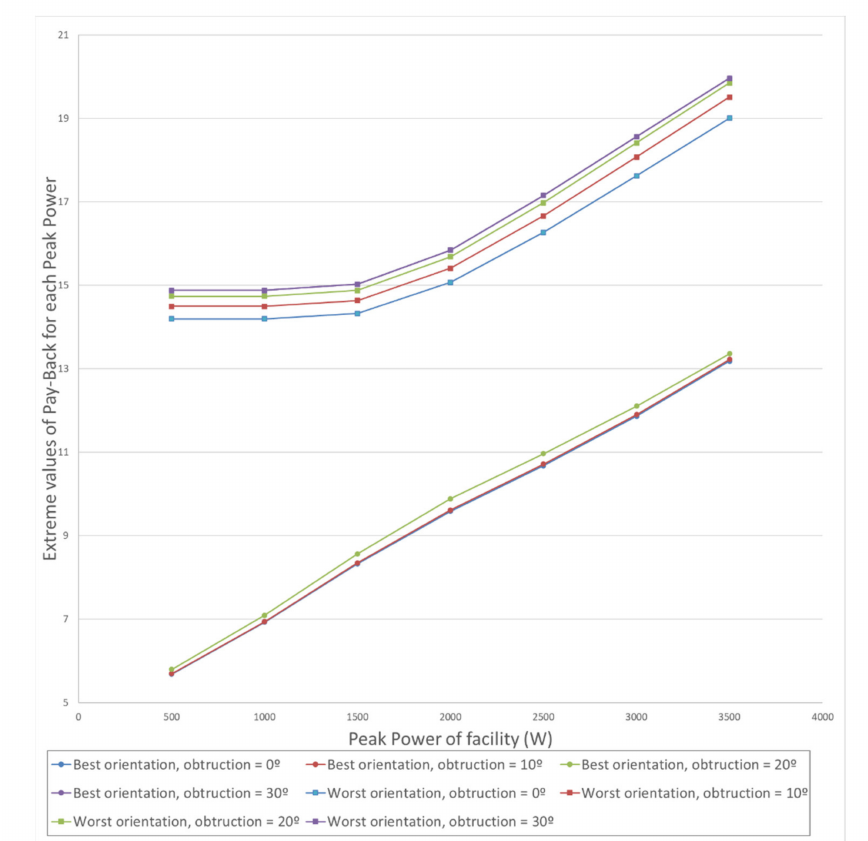
Figure 9. Achievable Pay − back depending on peak power and degree of